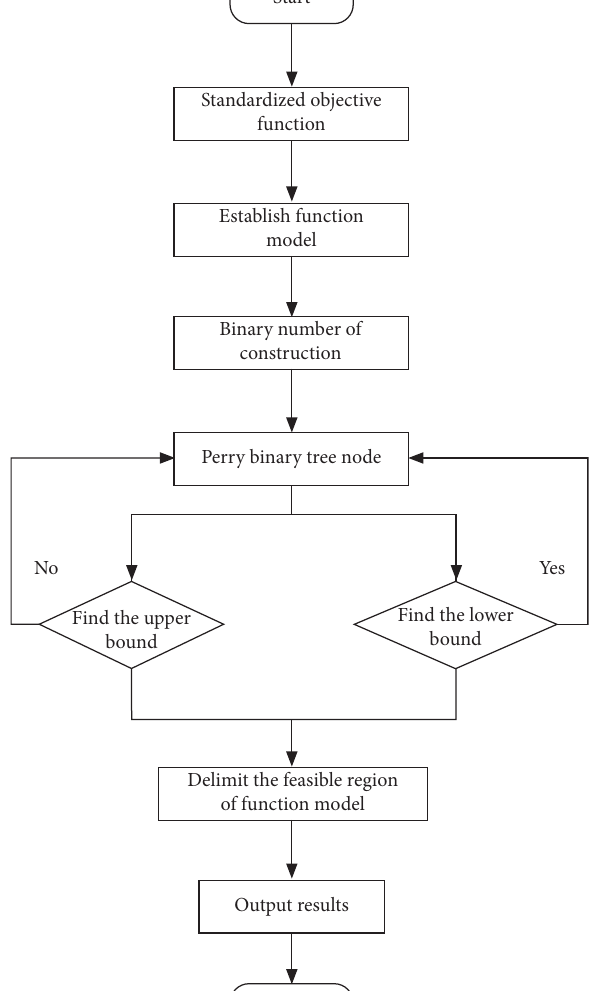
Figure 4: Design of the performance optimization